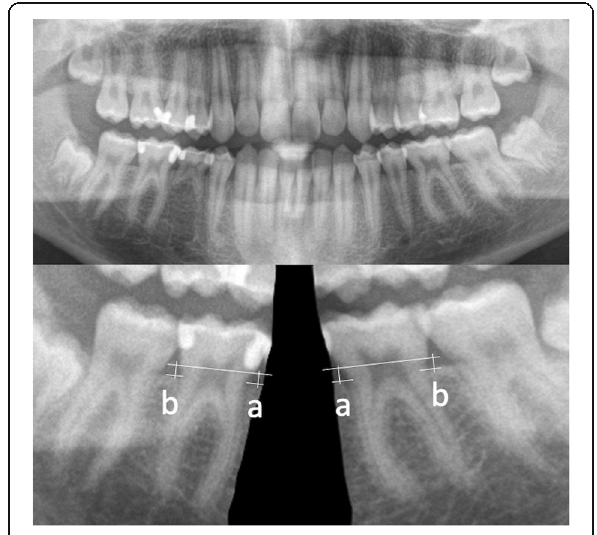
Fig. 2 Measurements of alveolar bone loss (ABL) at the mesial ( a ) and distal ( b ) side of the first molar. The lower images are cropped from the upper image to ensure blinding, and they are also magnified to ensure measurement